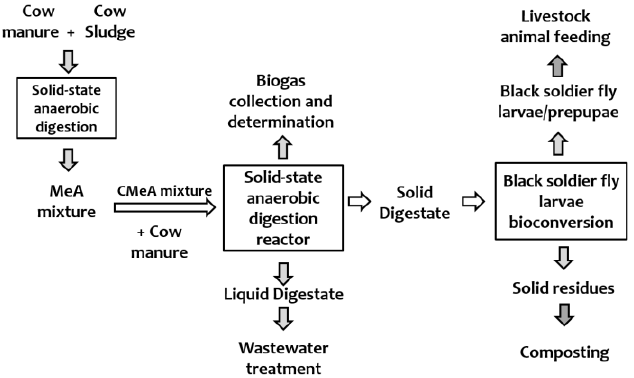
Figure 2. Flow chart of the two-step biological treatment system.